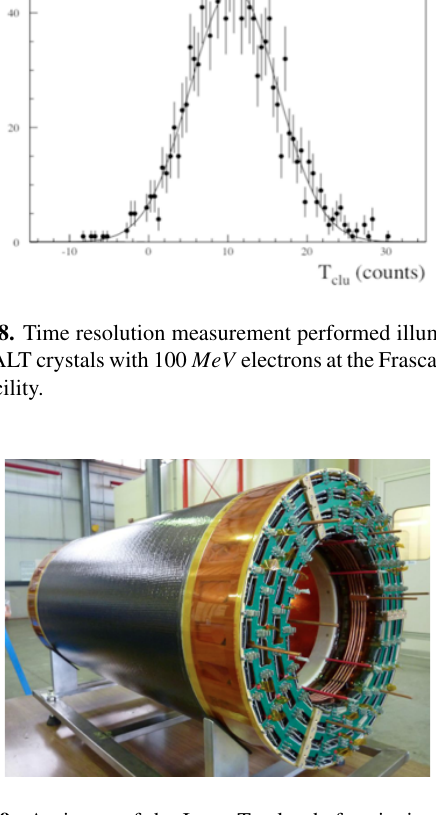
Figure 9. A picture of the Inner Tracker before its installation inside the KLOE interaction region.